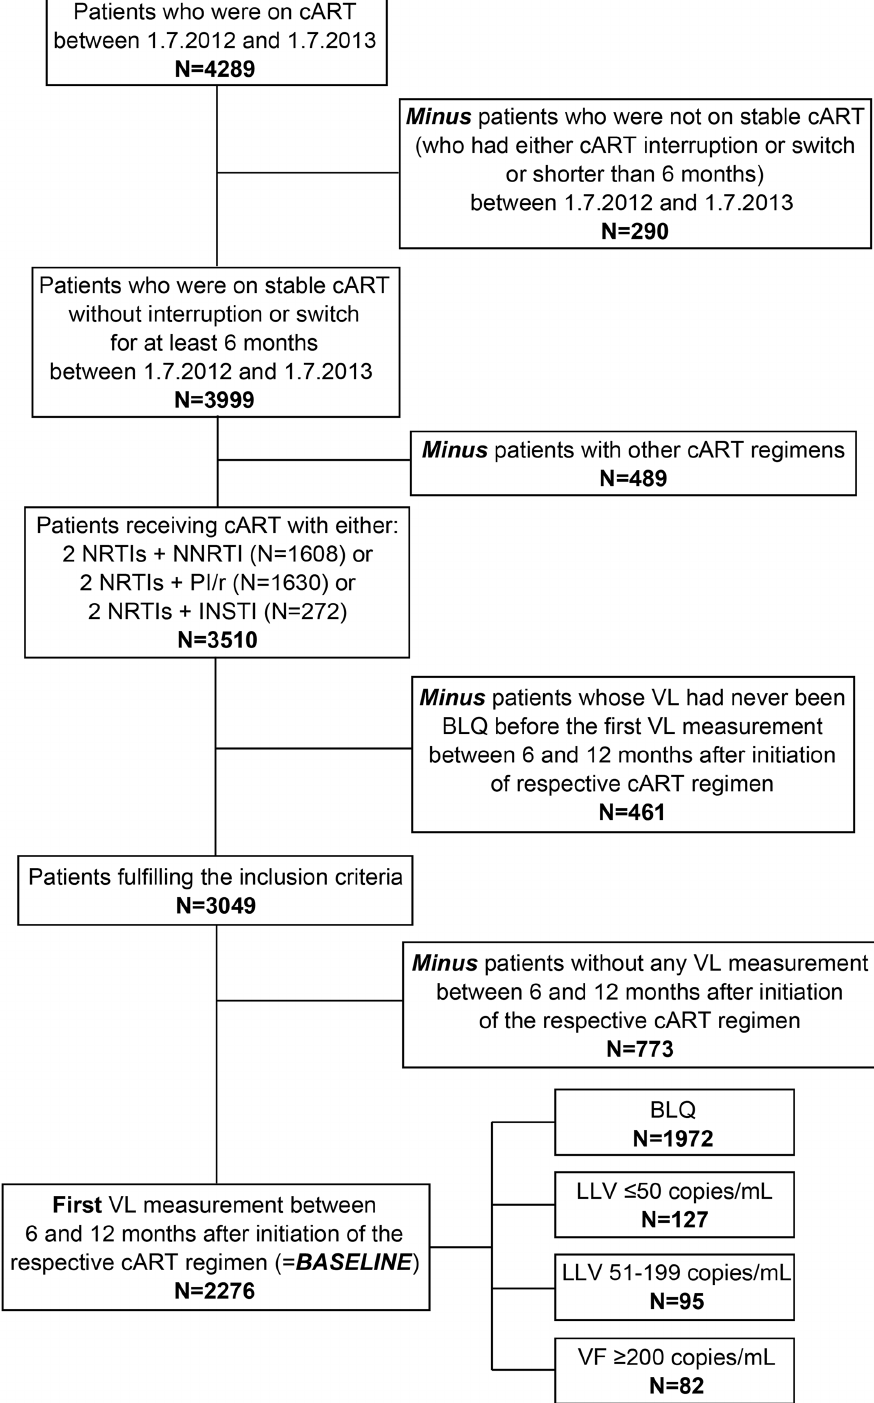
Fig 1. Flowchart of patient selection.